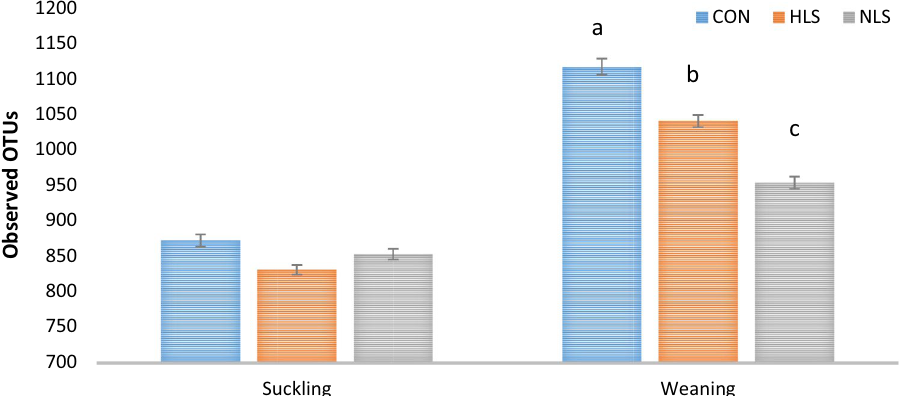
Figure 2. OTUs gain at the beginning (Suckling) and the end (weaning) of the experiment. CON, Control without probiotic; HLS, L. salivarius 144 isolated from fast-growing pig feces; NLS, L. salivarius 160 isolated from normal weight pig feces and different superscript letters indicate significant differences (P <